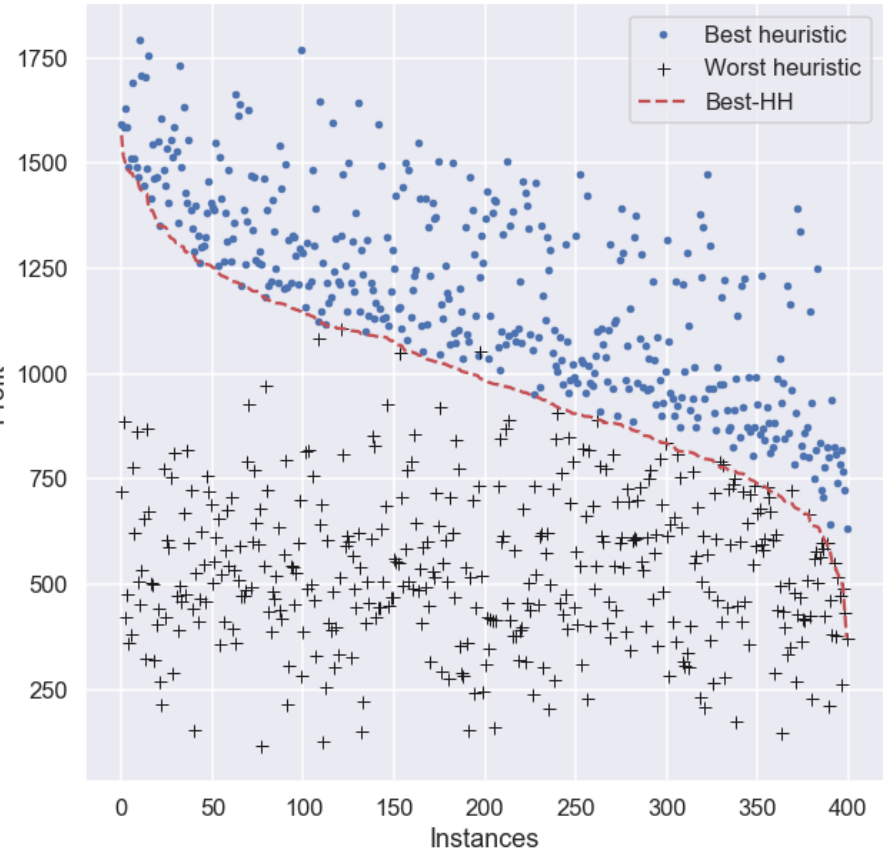
Figure 4. Profit per instance obtained by the best hyper-heuristic trained on set α 1 (removing MaxPW from the pool of available heuristics) and the best and worst heuristic per instance on set α 2 (including MaxPW in the